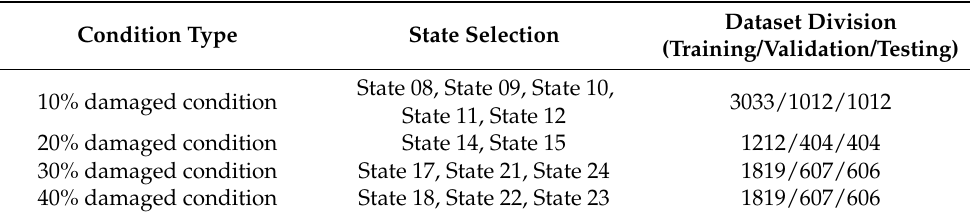
Table 2. Description of used